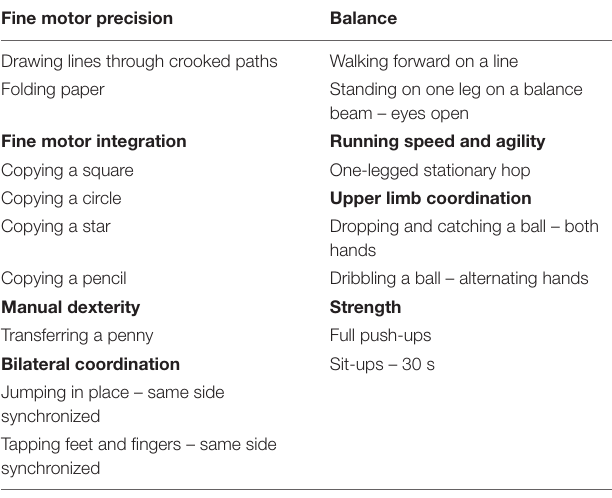
TABLE 1 | List of dimensions and items of the BOT-2 motor